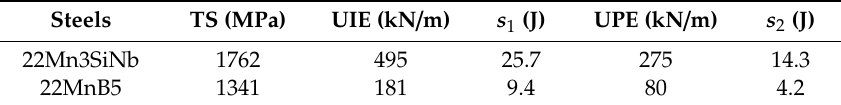
Table 4. Tear properties of two investigated steels.